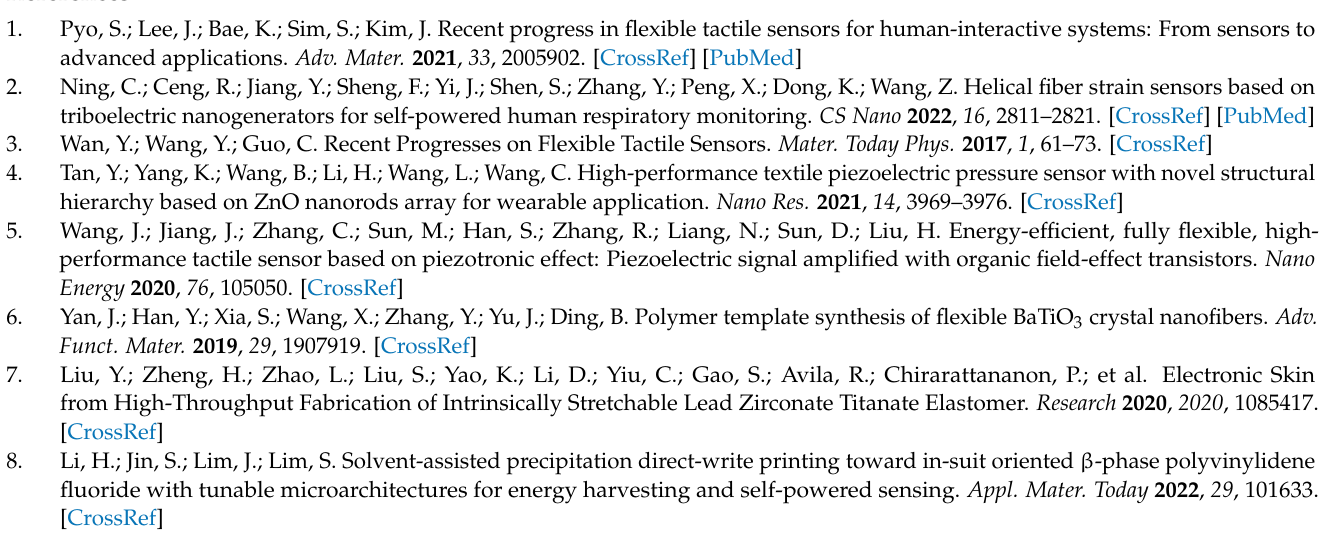
diagram; Figure S3: Interface toughness; Table S1: Summary of various self-powered sensors.